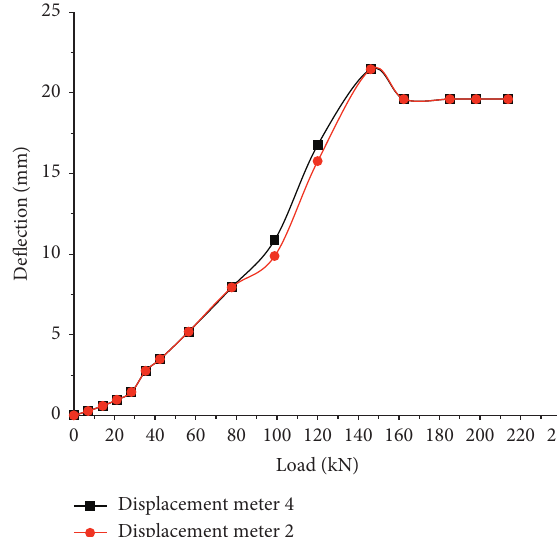
Figure 19: Deflection/load relation curves at different measuring points in the midspan of LPCSHTHSC along the short-span direction.